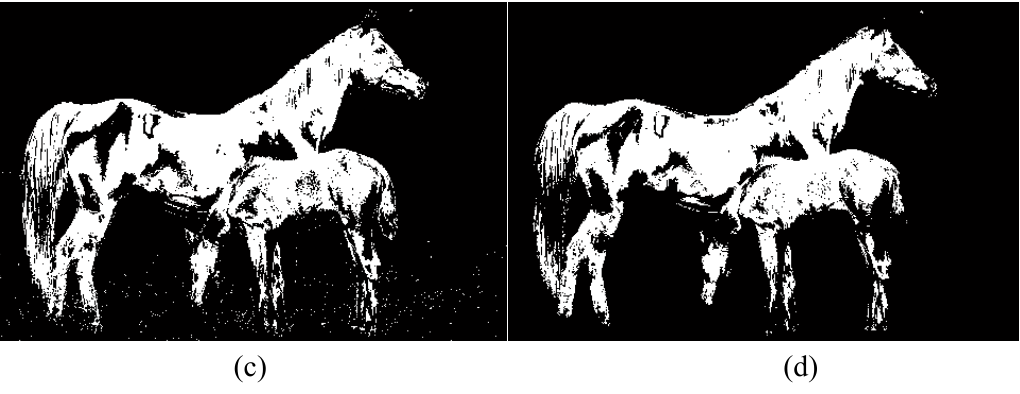
Figure 7. The segmentation result of “horse” image: (a) “horse” original image; (b) the result of KFCM_F; (c) the result of FCM_S; (d) the result of the proposed method.